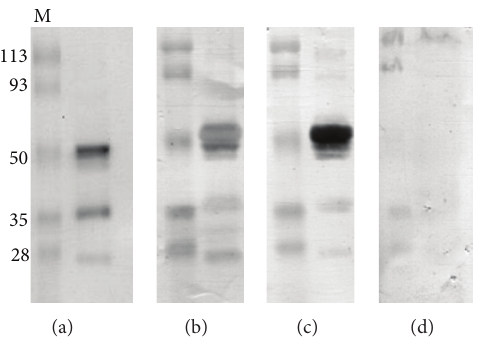
Figure 2: The Fc-binding reactivity of RFL11 clone using Western blot analysis. Panel (a) showed human Fc fragment on a Coomassie blue-stained polyacrylamide gel. After transferred onto the nitrocel- lulose membrane, the Fc fragments were detected by serum of HCV- infected patient with Sj¨ogren’s syndrome (b) and RFL11 (c) but not an irreverent Fab molecule in cellular lysate (d).